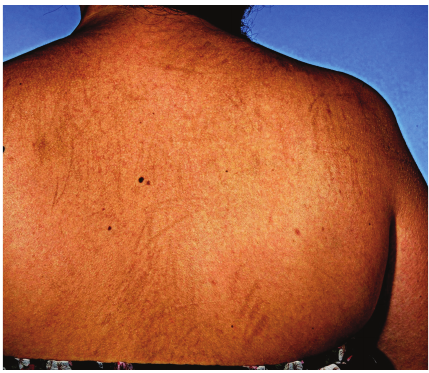
Figure 1: Fading flagellate dermatosis due to